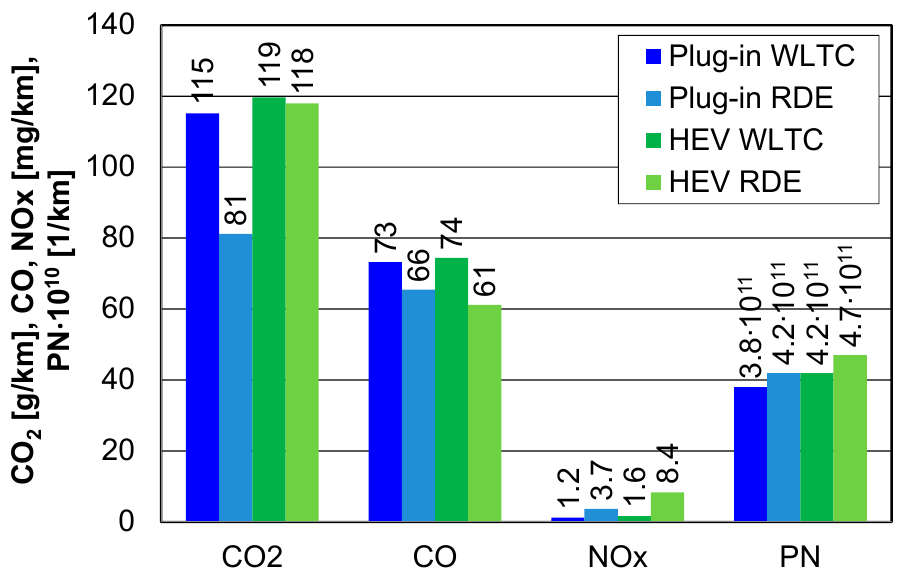
Figure 38. Comparison of on-road emissions of plug-in and HEV vehicles in WLTC and RDE tests. Significantly greater differences are observed in actual traffic conditions, where the plug-in vehicle emits about 30% less carbon dioxide. In addition, for this type of vehicle, there are lower nitrogen oxide emissions (by 50%) compared to the HEV, as well as particu- late matter numbers (about 10% lower). There were higher carbon monoxide emissions in the RDE test by about 6% for the plug-in vehicle compared to the HEV. The test results obtained clearly indicate that the potential for reducing emissions and fuel consumption is much higher for plug-in vehicles when used for short routes with a significant proportion of electric engine